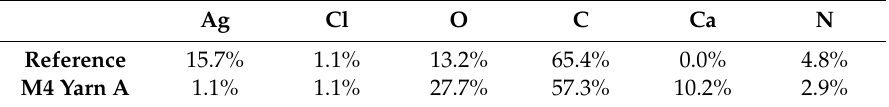
Table 4. Surface composition of M4 Yarn A.